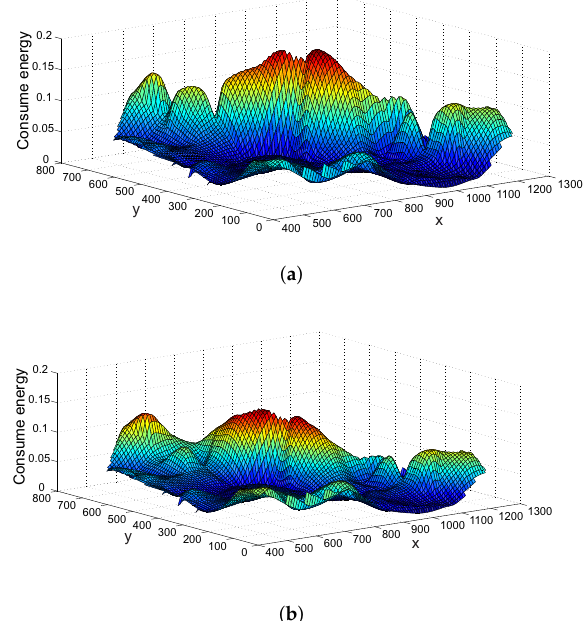
Figure 7. Energy consumption of nodes under using NCR and ANCR. ( a ) Energy consumption of nodes under using NCR. ( b ) Energy consumption of nodes under using